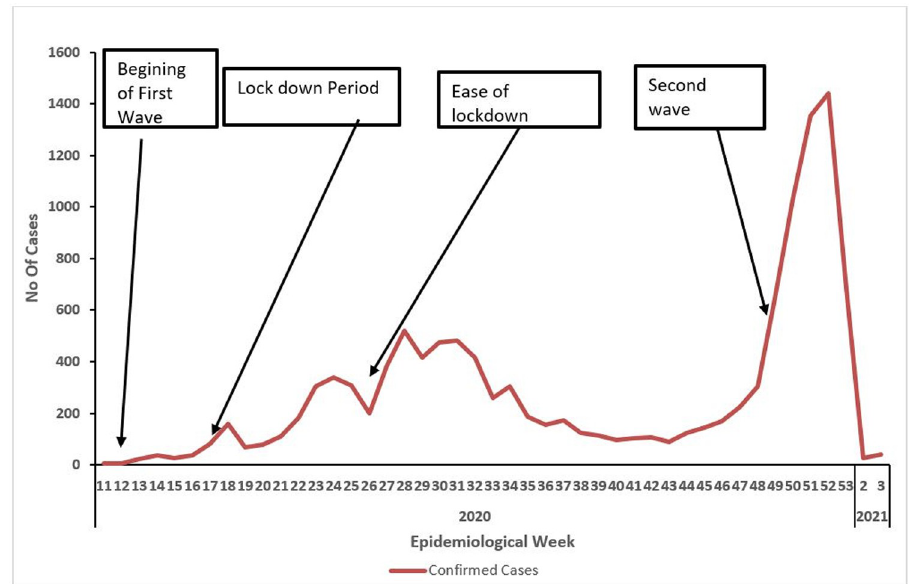
Fig 3. Trend of COVID-19 confirmed cases in FCT from March 2020—January